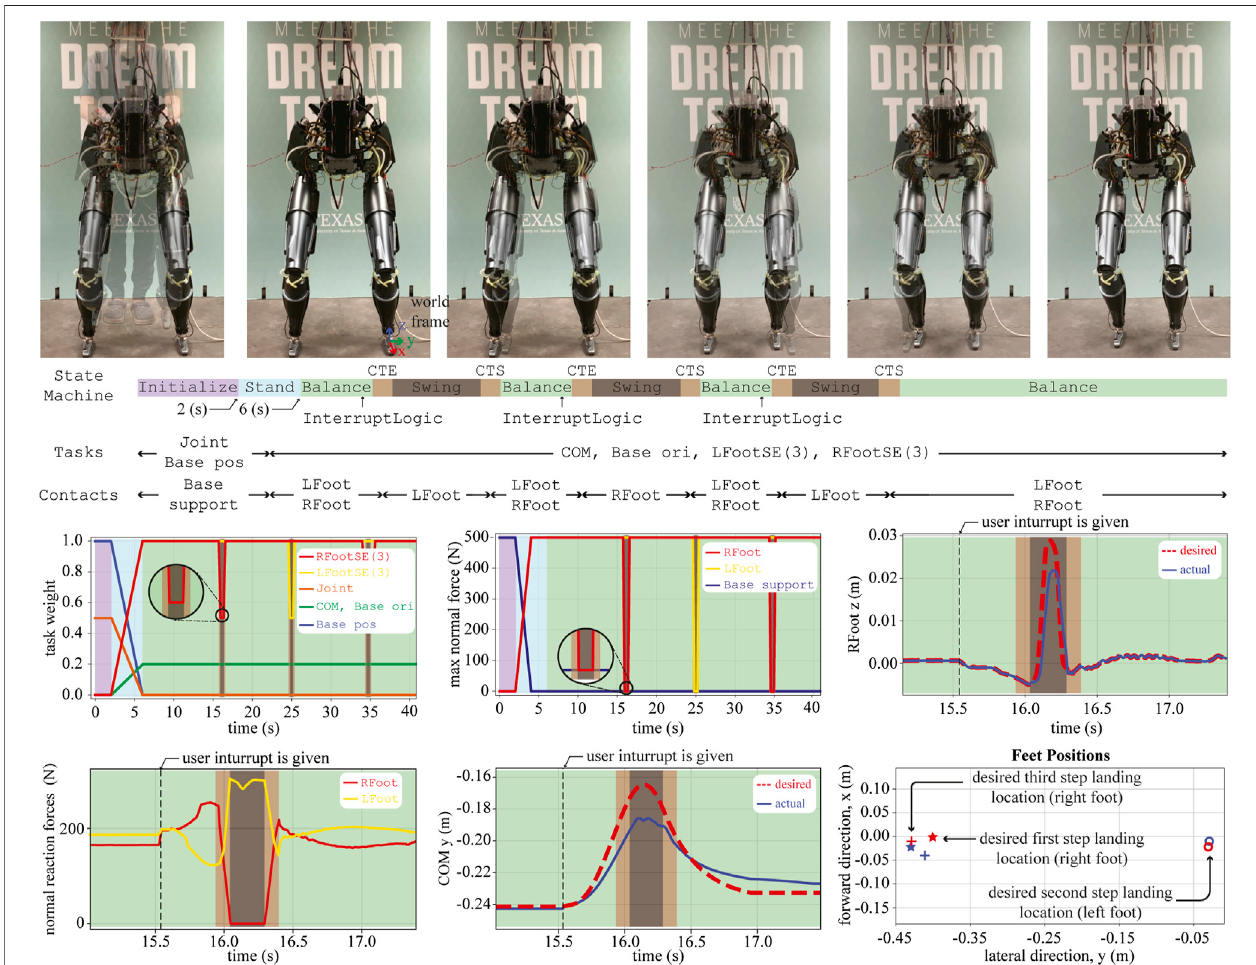
FIGURE 11 | A sequence of snapshots for the step-and-stop experiment are shown. Different sets of tasks and contacts are considered for each behavior phase. Similarly to the balancing experiment, we show the task weights and the maximum normal forces throughout the experiment. The motion in the vertical direction of the swingfoot(i.e.,RFootz)andthelateralCOMtrajectories(i.e.,COMy)arealsoshown.Thenormaldirectionofthereactionforcecommands(i.e., f * r )atbothfeetcomputed by IHWBC are also shown. Finally, three sets of desired and actual foot landing locations during the experiments are depicted, where the red and blue color represent the desired and actual positions,